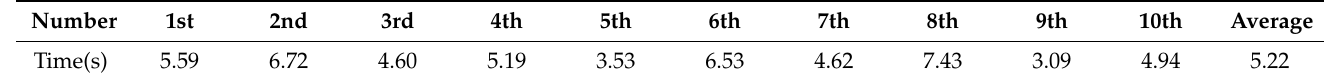
Table 2. Time of spoofing interference detection.